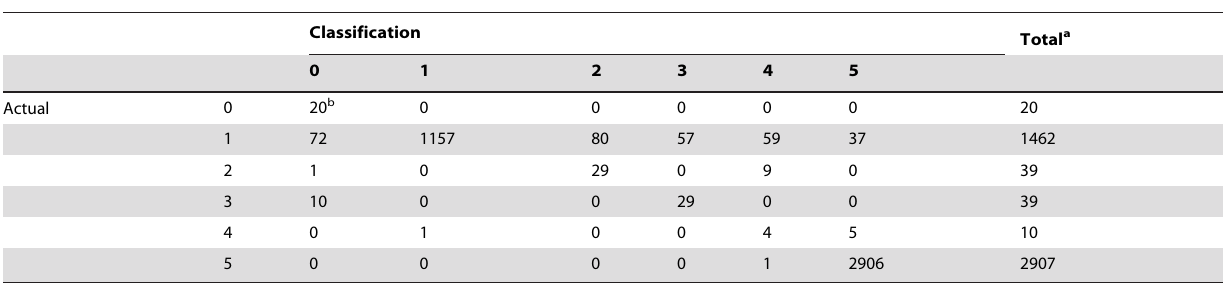
Table 2. Simulation result: Two-Step Model.